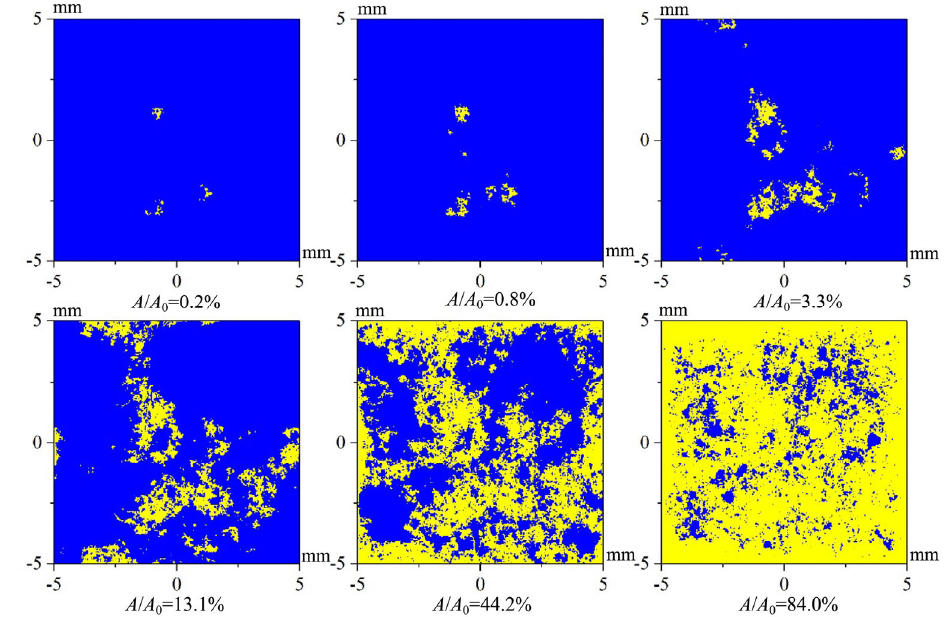
Fig. 4 Evolution of real contact area and pressure